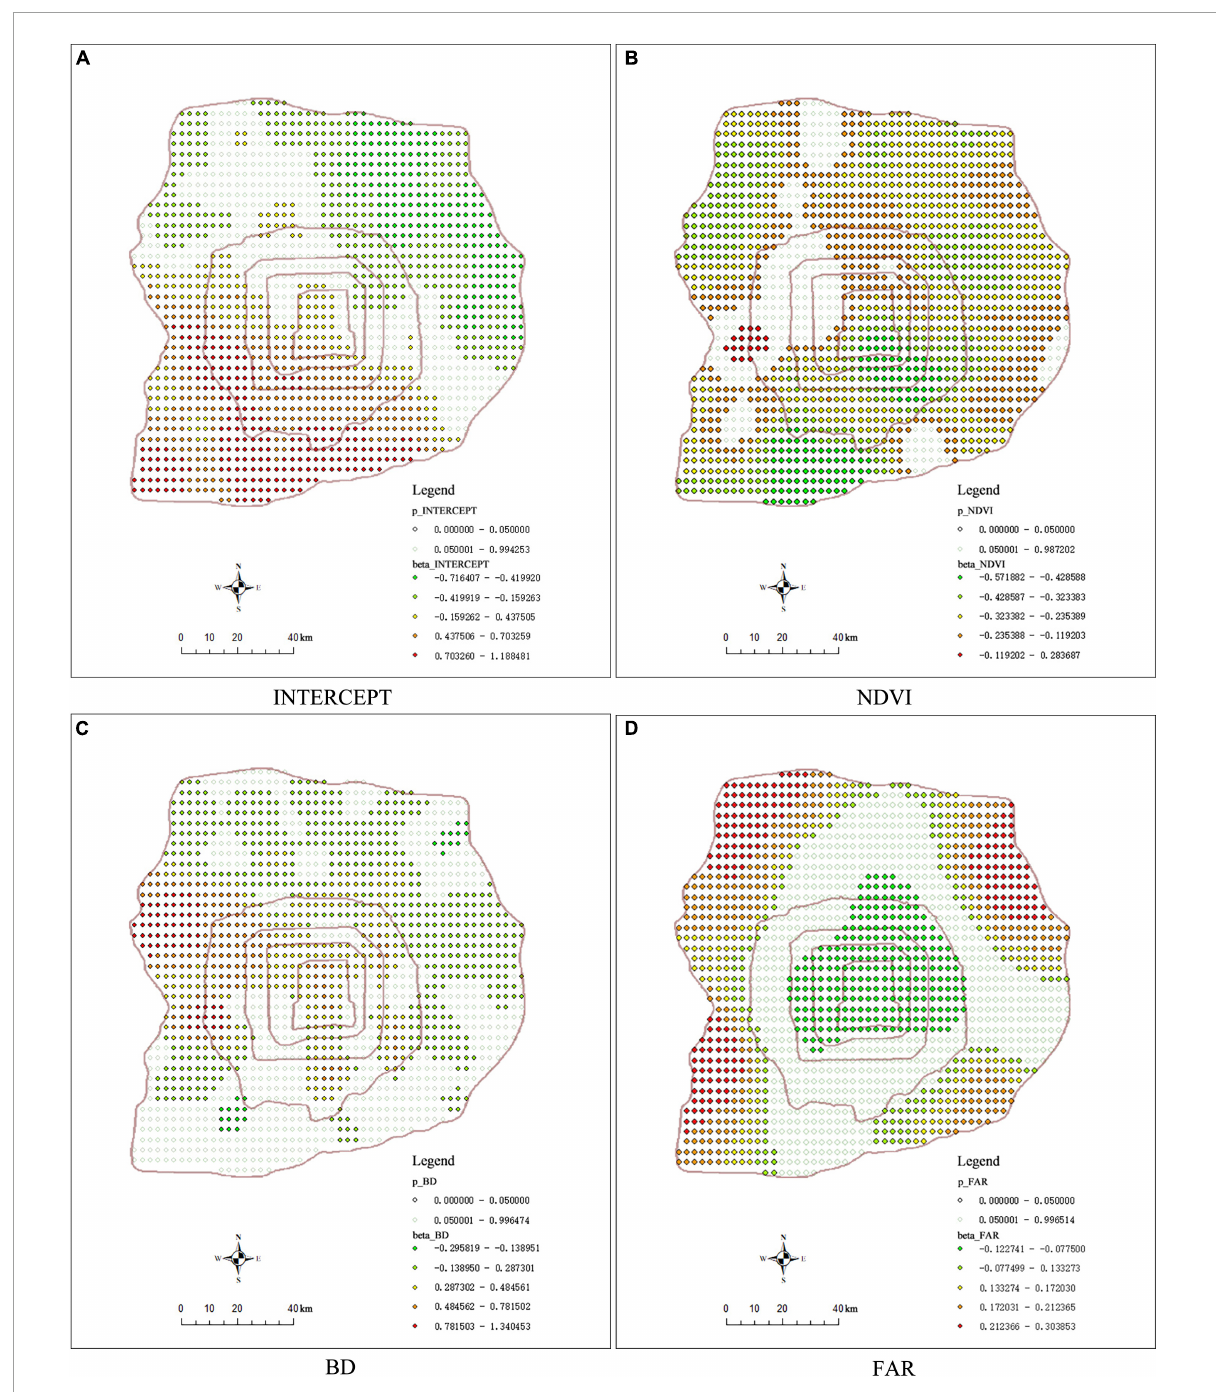
FIGURE8 Spatial patterns of coefficients in the MGWR.